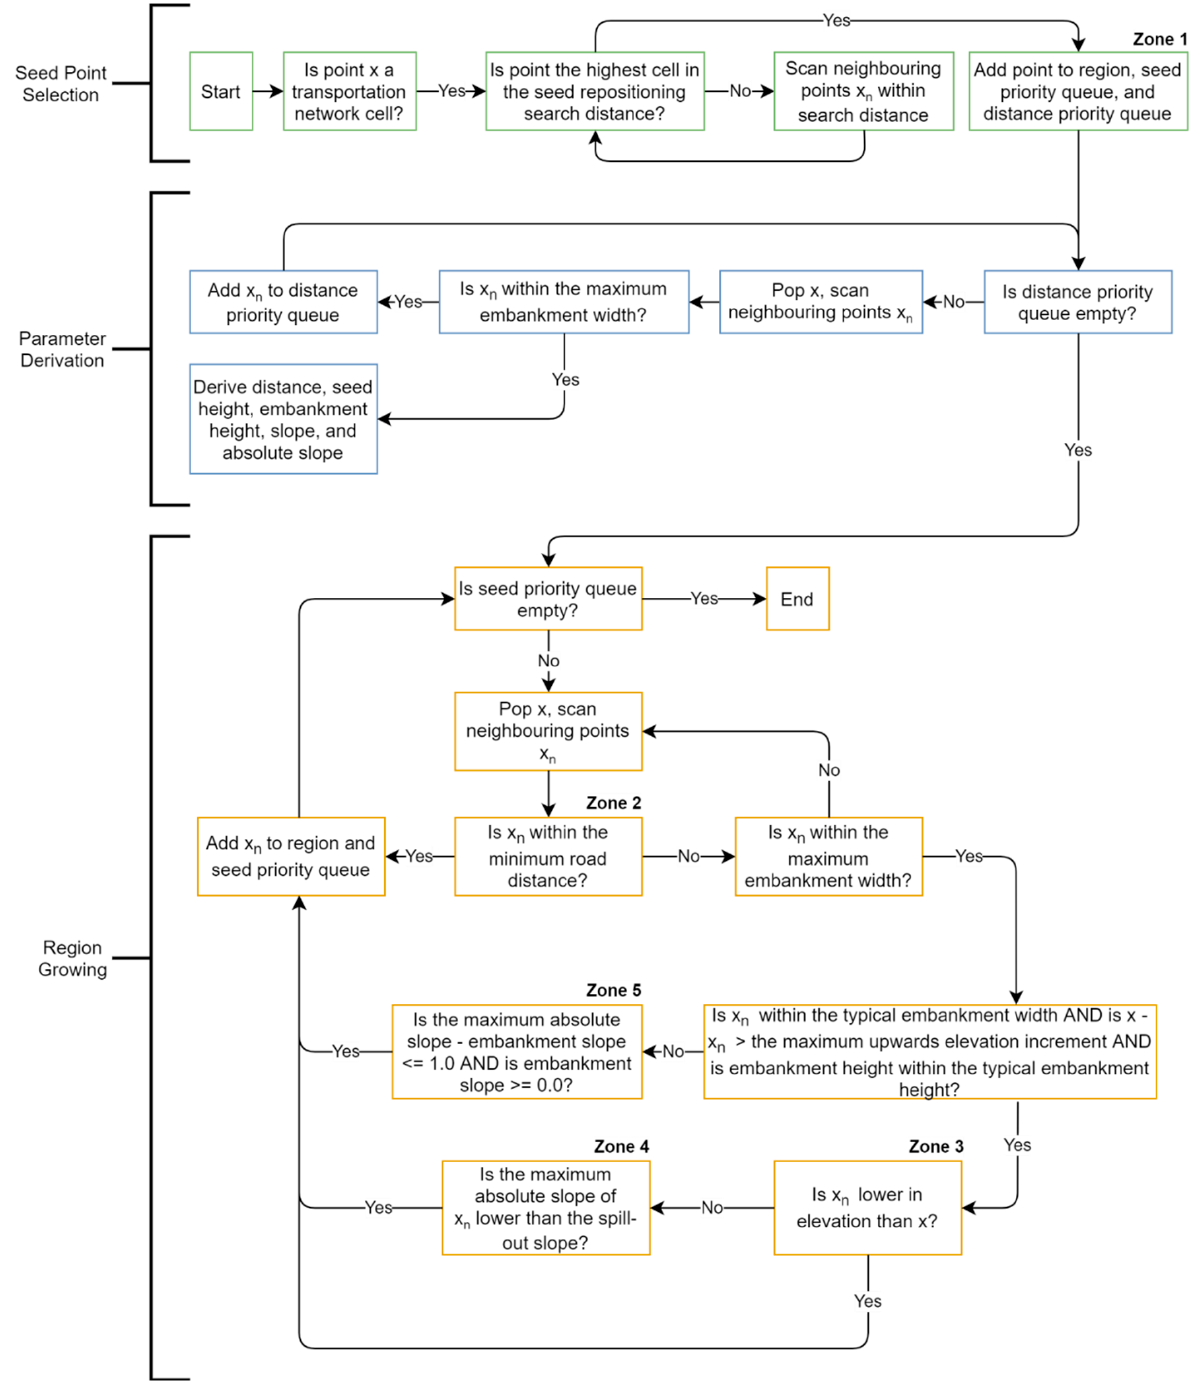
Figure 2. Seed point selection, parameter derivation, and region growing algorithm for the identification of embankments.